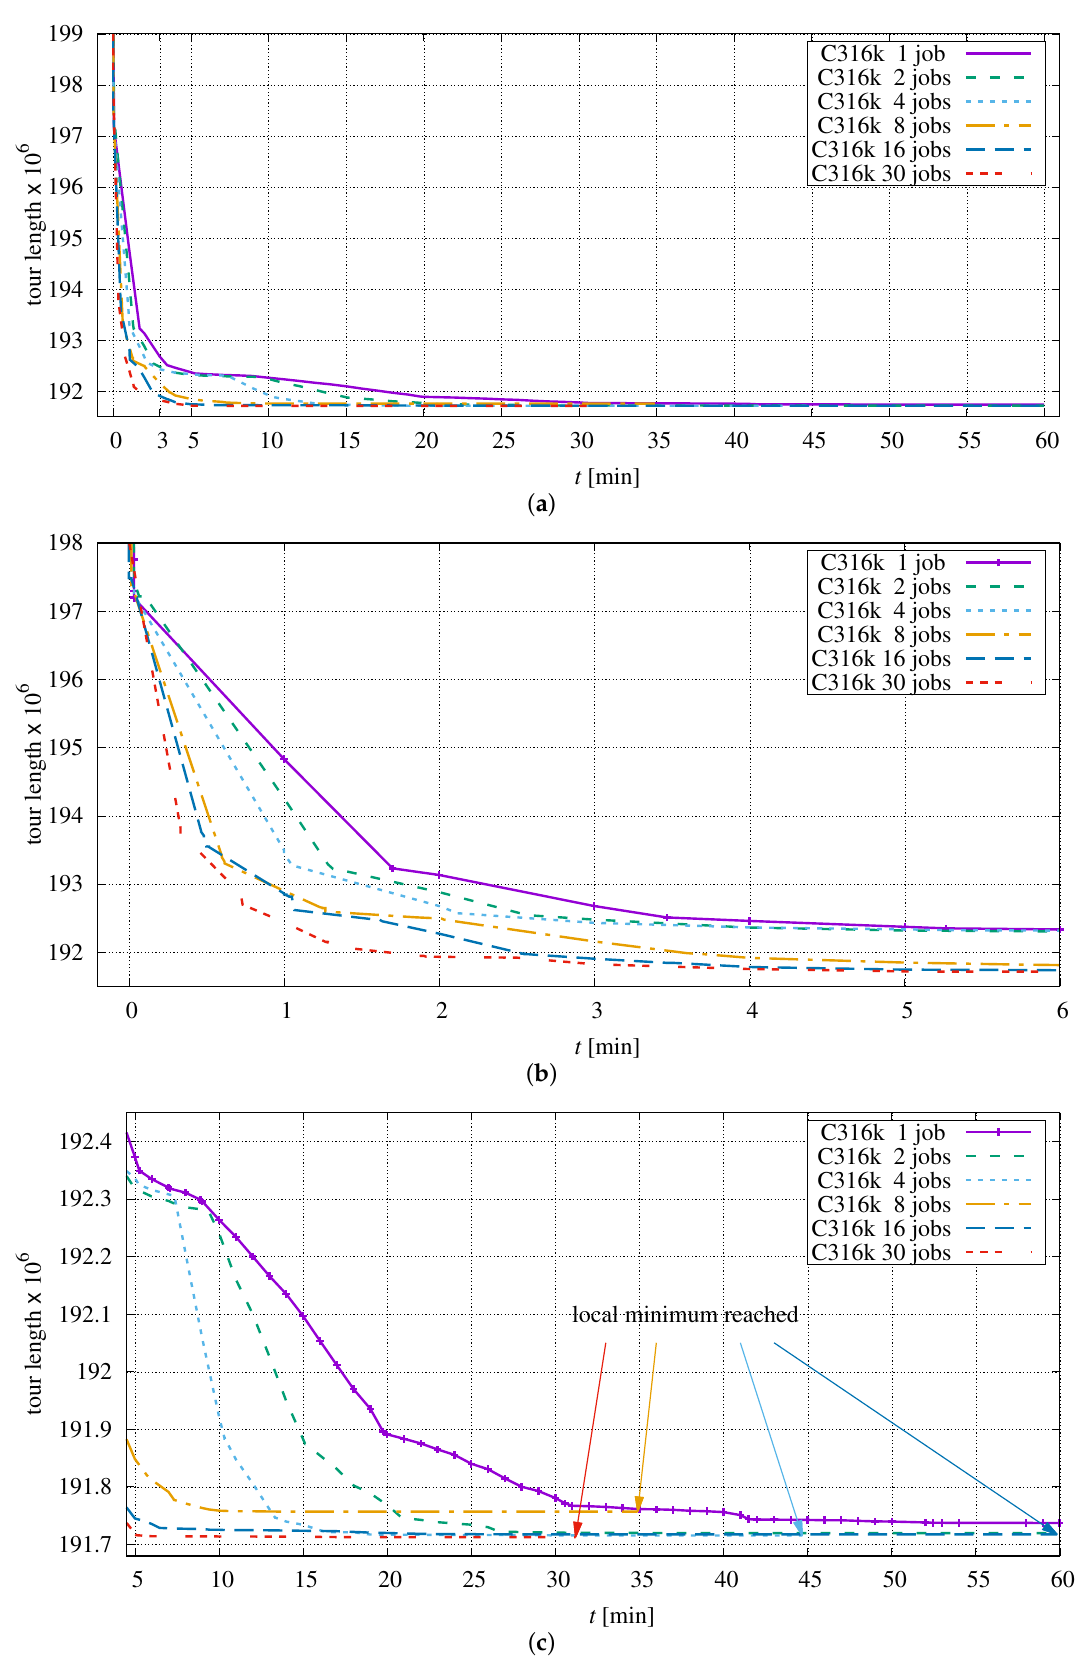
Figure 15. Progress of optimization dependent on the number of parallel jobs in application to C316k.0: ( a ) over full duration, ( b ) first six minutes, ( c ) last 55